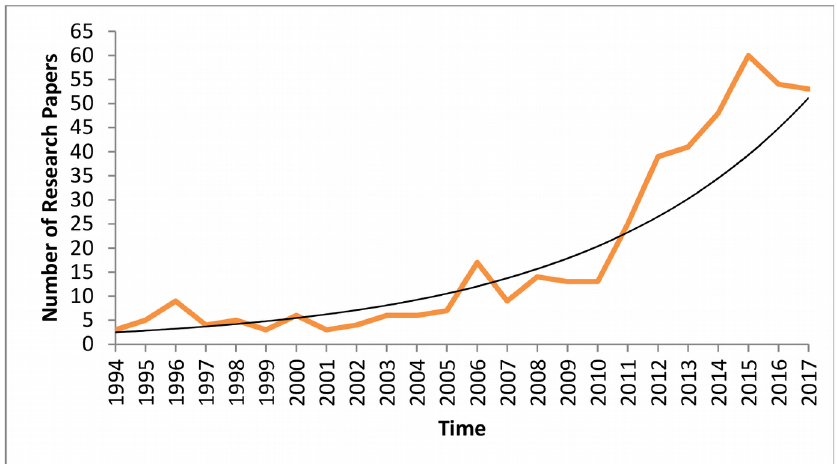
Figure 1. Lean publications over the years